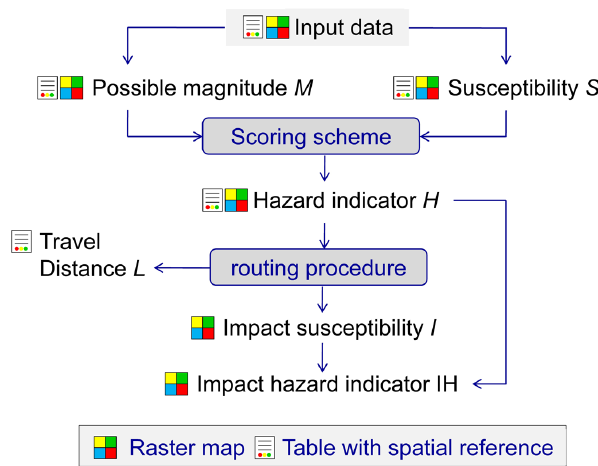
Fig. 5. Simplified logical framework valid for each of the four mod- ules r.rockslide, r.iceaval, r.periflow and r.glof. The specific charac- teristics of each module are outlined in Sects.